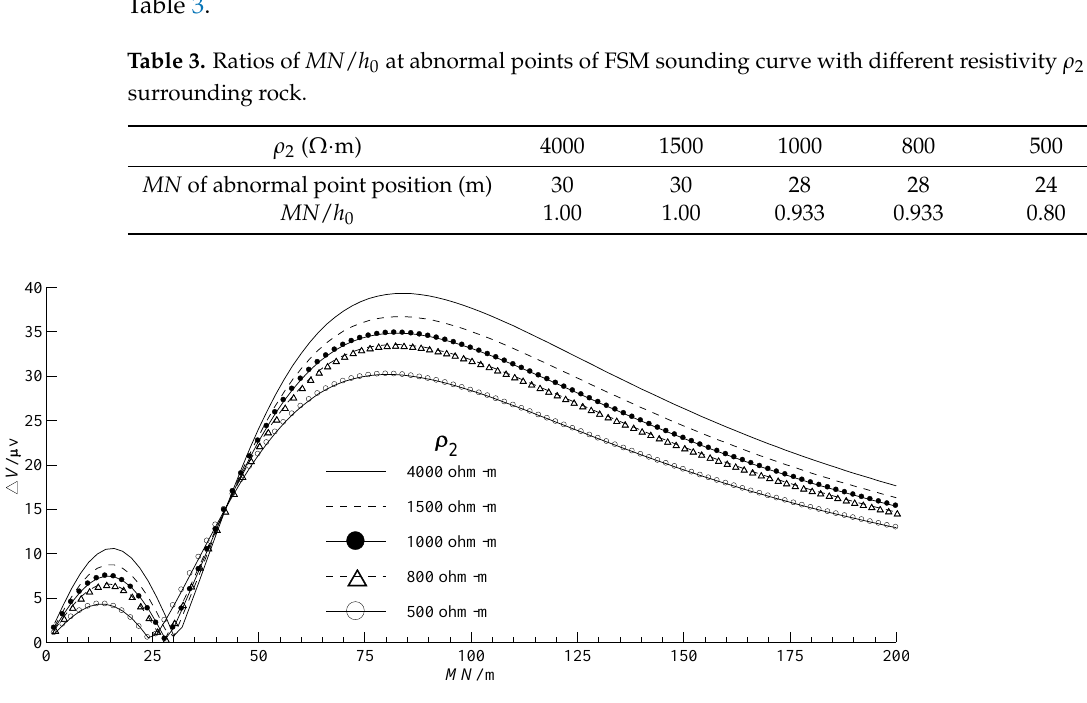
Figure 7. Forward calculating curves of FSM sounding for different resistivity ρ 2. Table 3. Ratios of MN / h 0 at abnormal points of FSM sounding curve with different resistivity ρ 2 of surrounding rock.